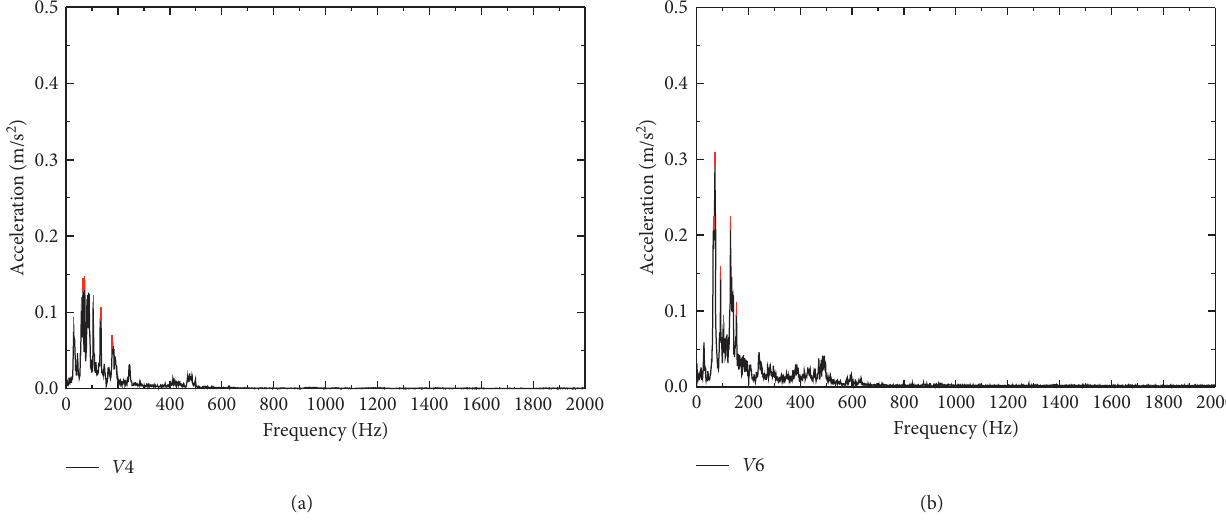
Figure 8: Vibration spectra for points (a) V 4 and (b) V 6 on the sound insulation plates.